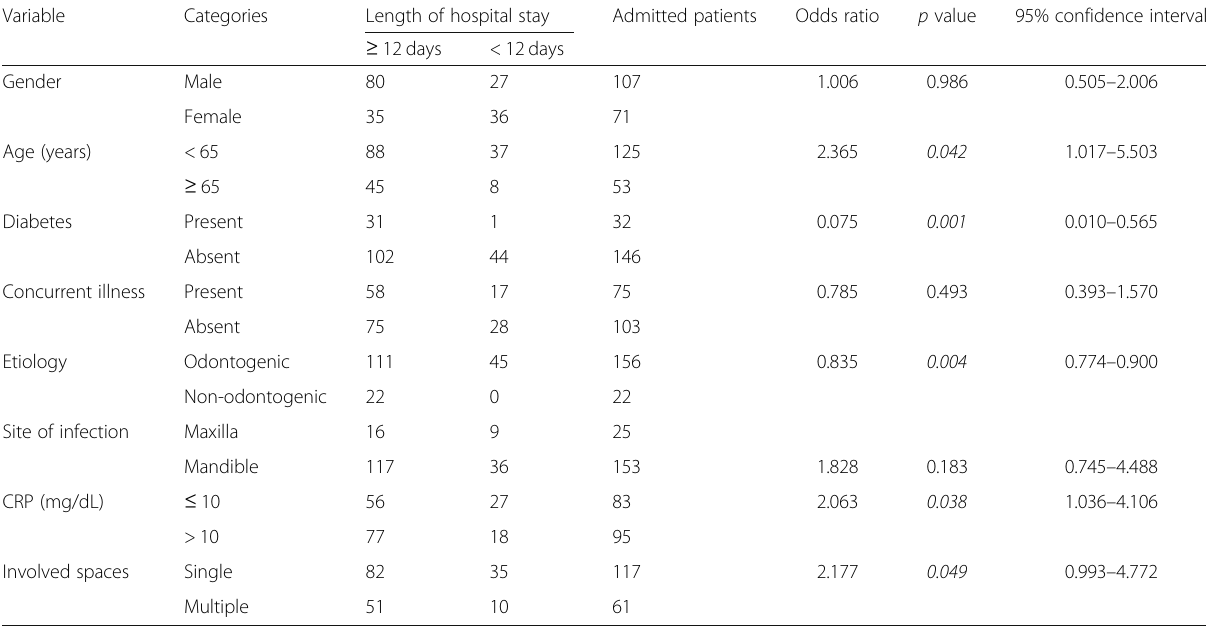
Table 4 Admitted patient characteristics and longer admission days — univariable analysis